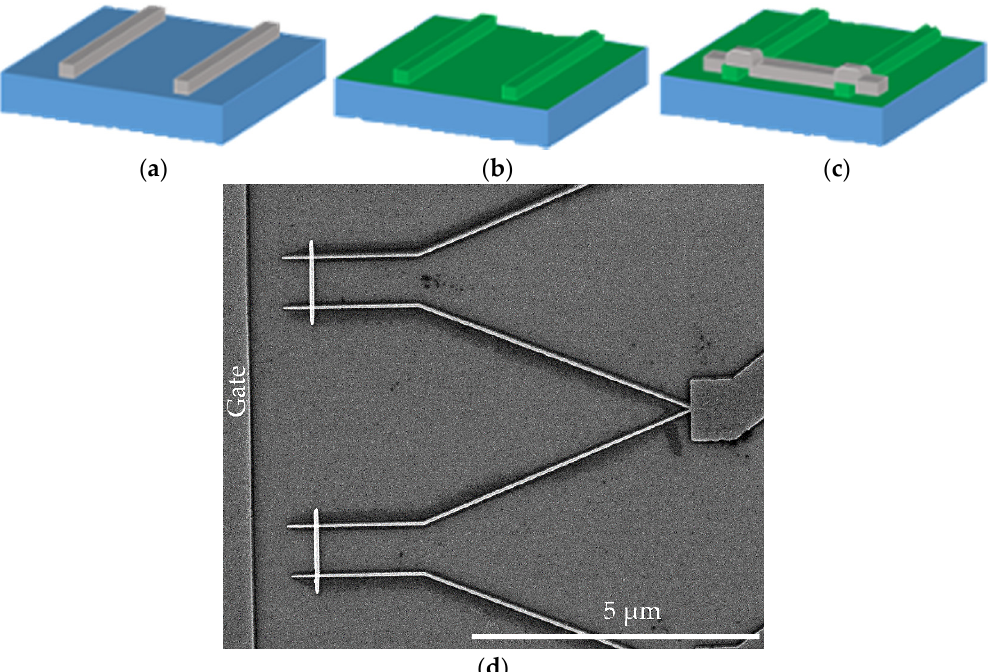
Figure 1. “Cross ‐ tie” fabrication of single electron transistors (SETs): ( a ) the metal source and drain (shown in grey) are deposited on thermal SiO 2 (shown in blue) using electron beam lithography (EBL) and liftoff; ( b ) the sample is blanket coated by a dielectric (shown in green) using atomic layer deposition (ALD) to form the tunnel barrier (usually about 1 nm thick); ( c ) EBL and liftoff are used to form the metal island of the single electron transistor (SET) (shown in grey); and ( d ) micrograph of two cross ‐ tie SETs. The wide line on the far left is the gate electrode and the narrow vertical lines are the metal islands.